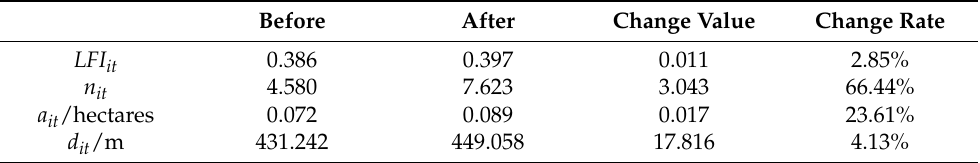
Table 4. Changes of LF before and after land transfer.